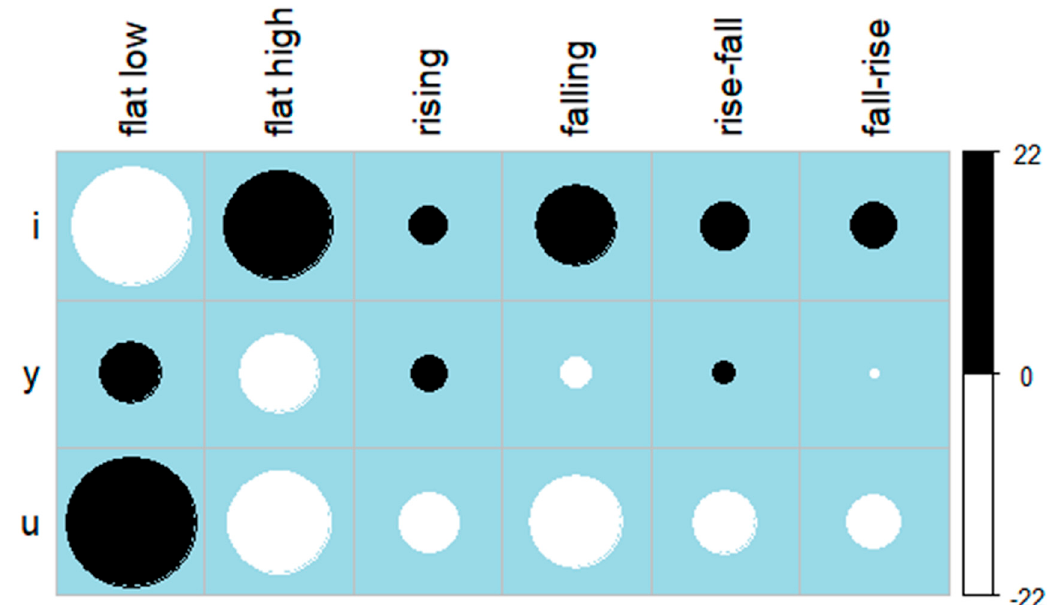
Figure 5. Correlation plot showing residuals of profile type and vowel. Black circles represent positive